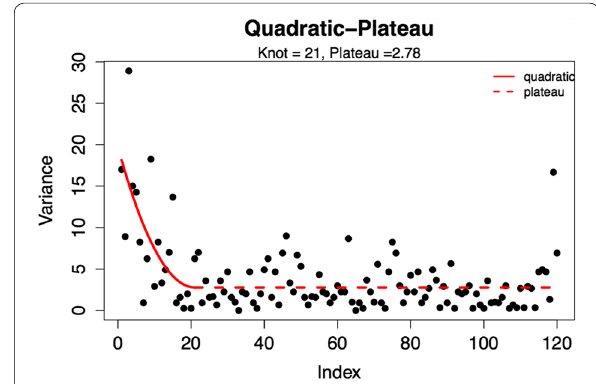
Fig. 2 Segmental polynomial (knot) regression of within-subject vari- ance showing a plateau (knot) at subject